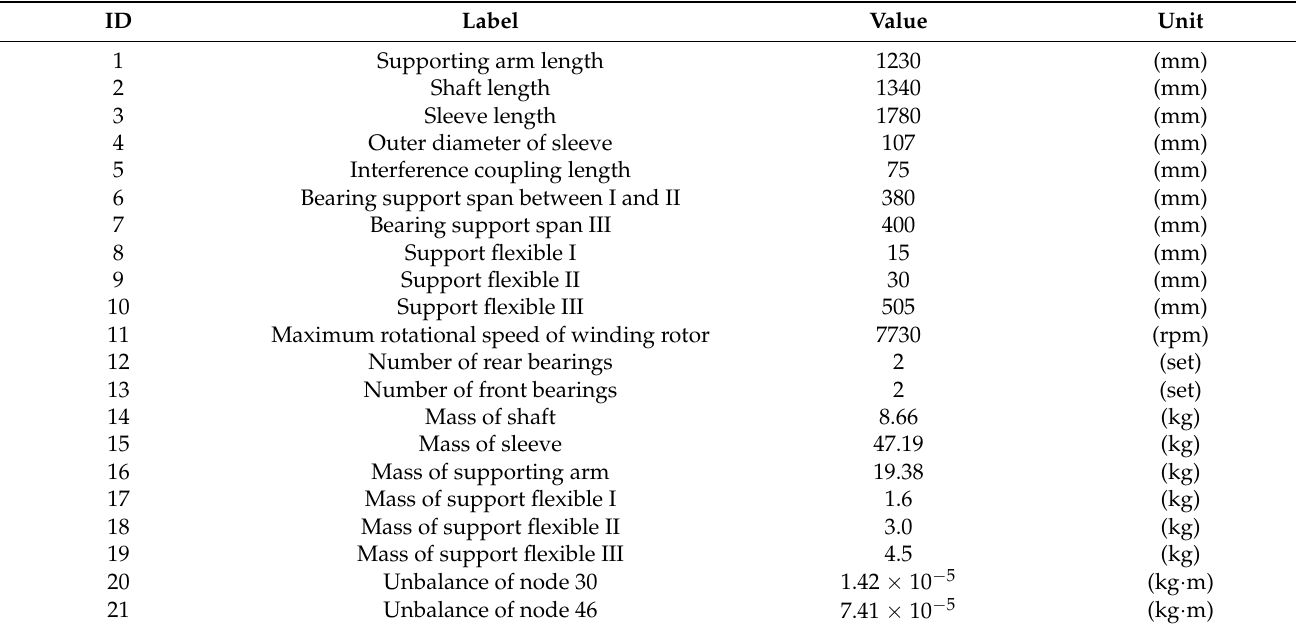
Table 2. Parameters of the high-speed winding